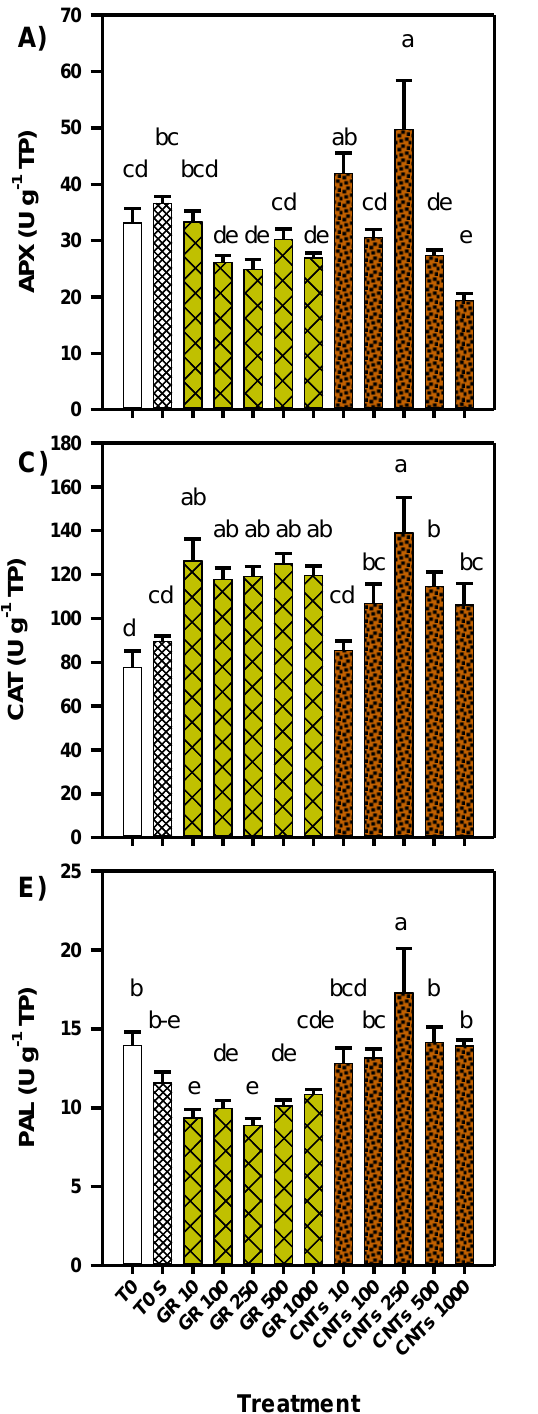
Figure 6. Enzymatic activity in leaves of tomato seedlings treated with carbon nanomaterials. Each data point is the average of five replicates ± standard error. Di ff erent letters indicate significant di ff erences between treatments according to Fisher’s least significant di ff erence test ( p ≤ 0.05). T0: absolute control. T0 S: sonicated control. GR: graphene. CNTs: carbon nanotubes. PAL: phenylalanine ammonia